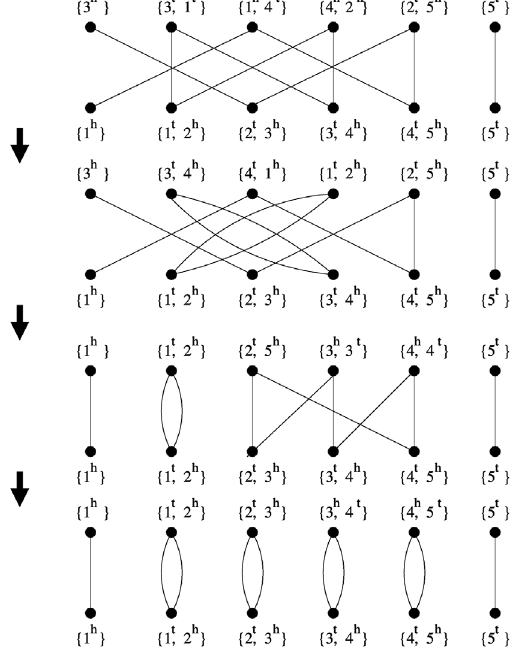
Figure 3. Adjacency graphs of each stage of one DCJ sorting sequence that transforms (3 2 1 2 4 2 5) to (1 2 3 4